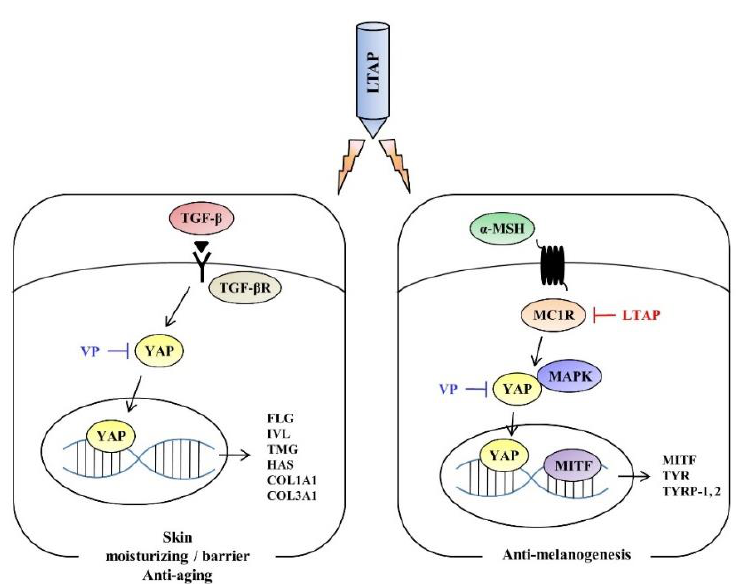
Figure 9. LTAP mechanism for skin moisturizing and melanogenesis. LTAP significantly increased the barrier, moisture content-related and aging factors in skin cells, and suppressed melanogenesis in melanoma cell lines through YAP regulation.